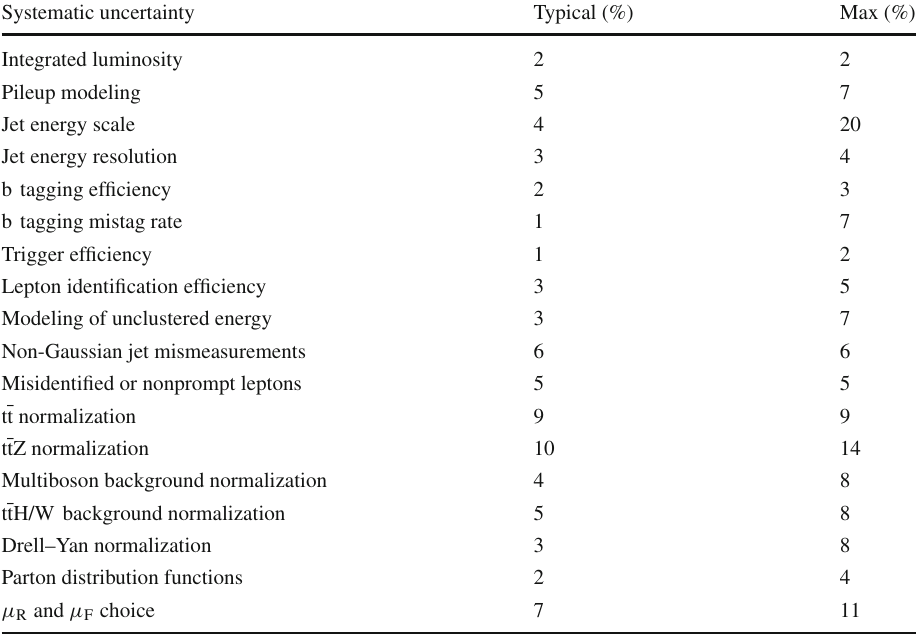
Table 5 Typical values (90% quantiles) and maximum values of the systematic uncertainties in all signal